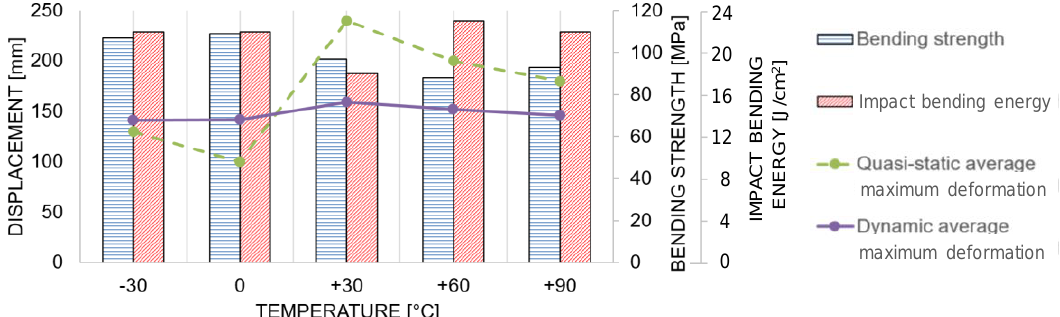
Figure 17. Mean values of bending strength and impact bending energy as well as the average maximum deformation of the quasi-static and dynamic tests over temperature.